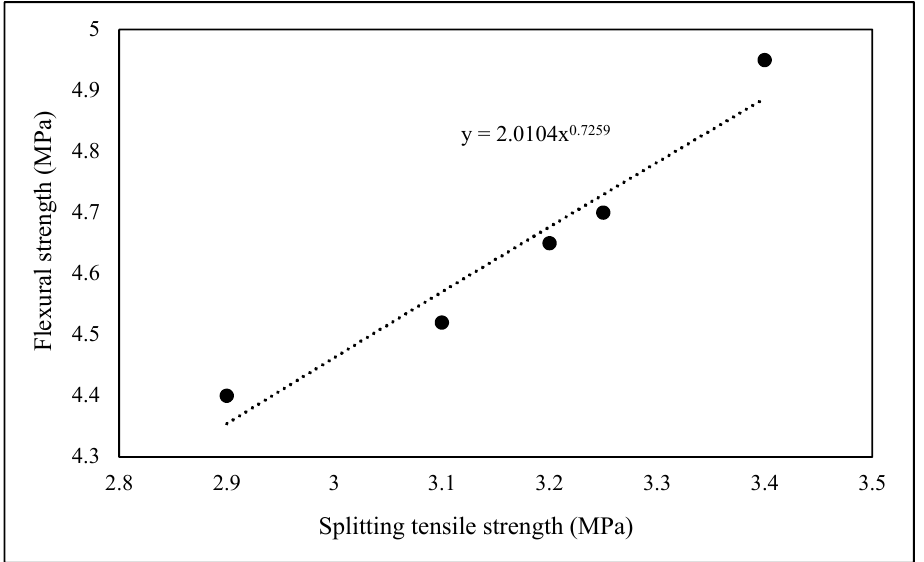
Figure 7. A meaningful correlation between flexural strength and splitting tensile strength, and an equation for estimation of 28th-day flexural strength from splitting tensile strength.